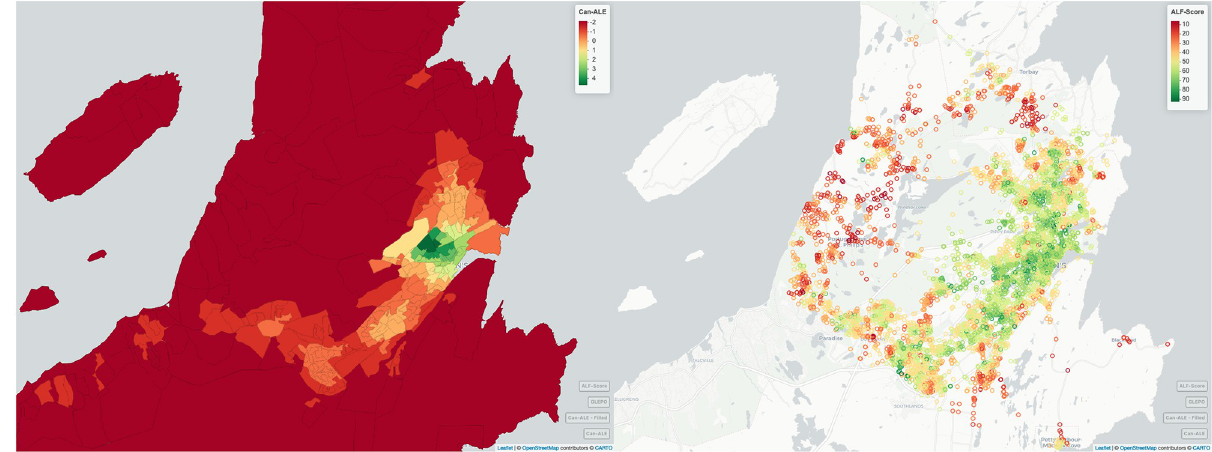
Fig 6. A comparison between Can–ALE and ALF–Score for the city of St. John’s, NL. Can–ALE (left) and ALF–Score (right). Dark green is most walkable, dark red is least walkable. Can–ALE’s scores may be rendered useless due to its over generalization. (Maps generated through RStudio [31] Version 1.2 using mapview package from rstudio.com with OpenStreetMap used as its base